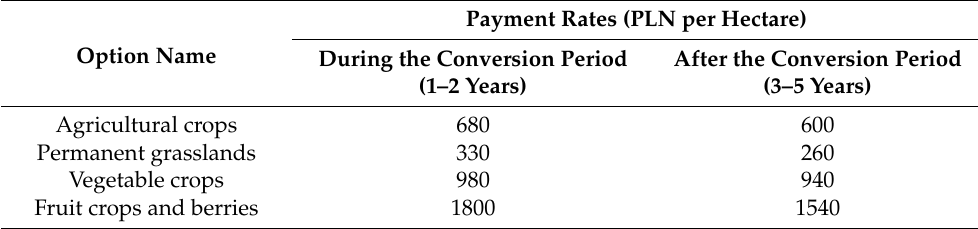
Table 1. Organic payment rates under the 2004–2006